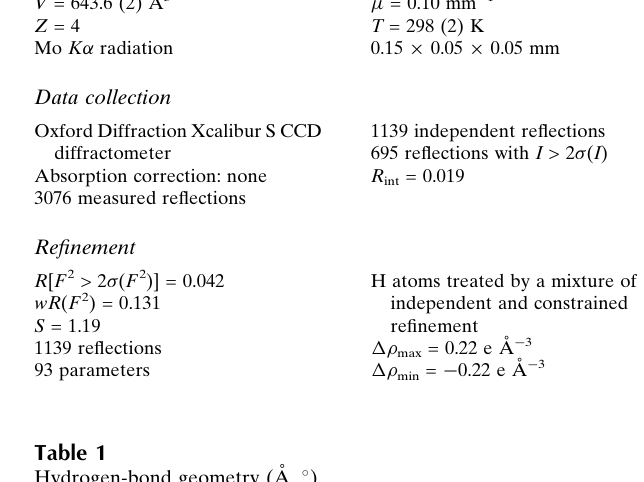
Hydrogen-bond geometry (A˚ , (cid:1)